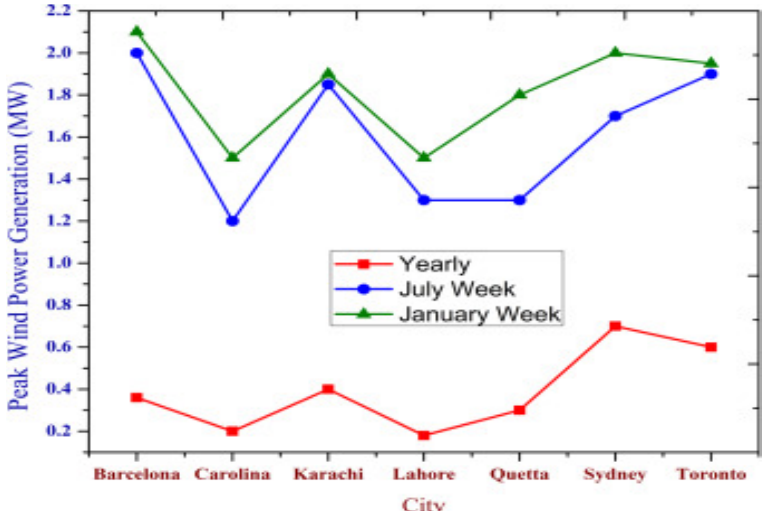
Figure 5. Graph of peak power generation by wind turbine [11]